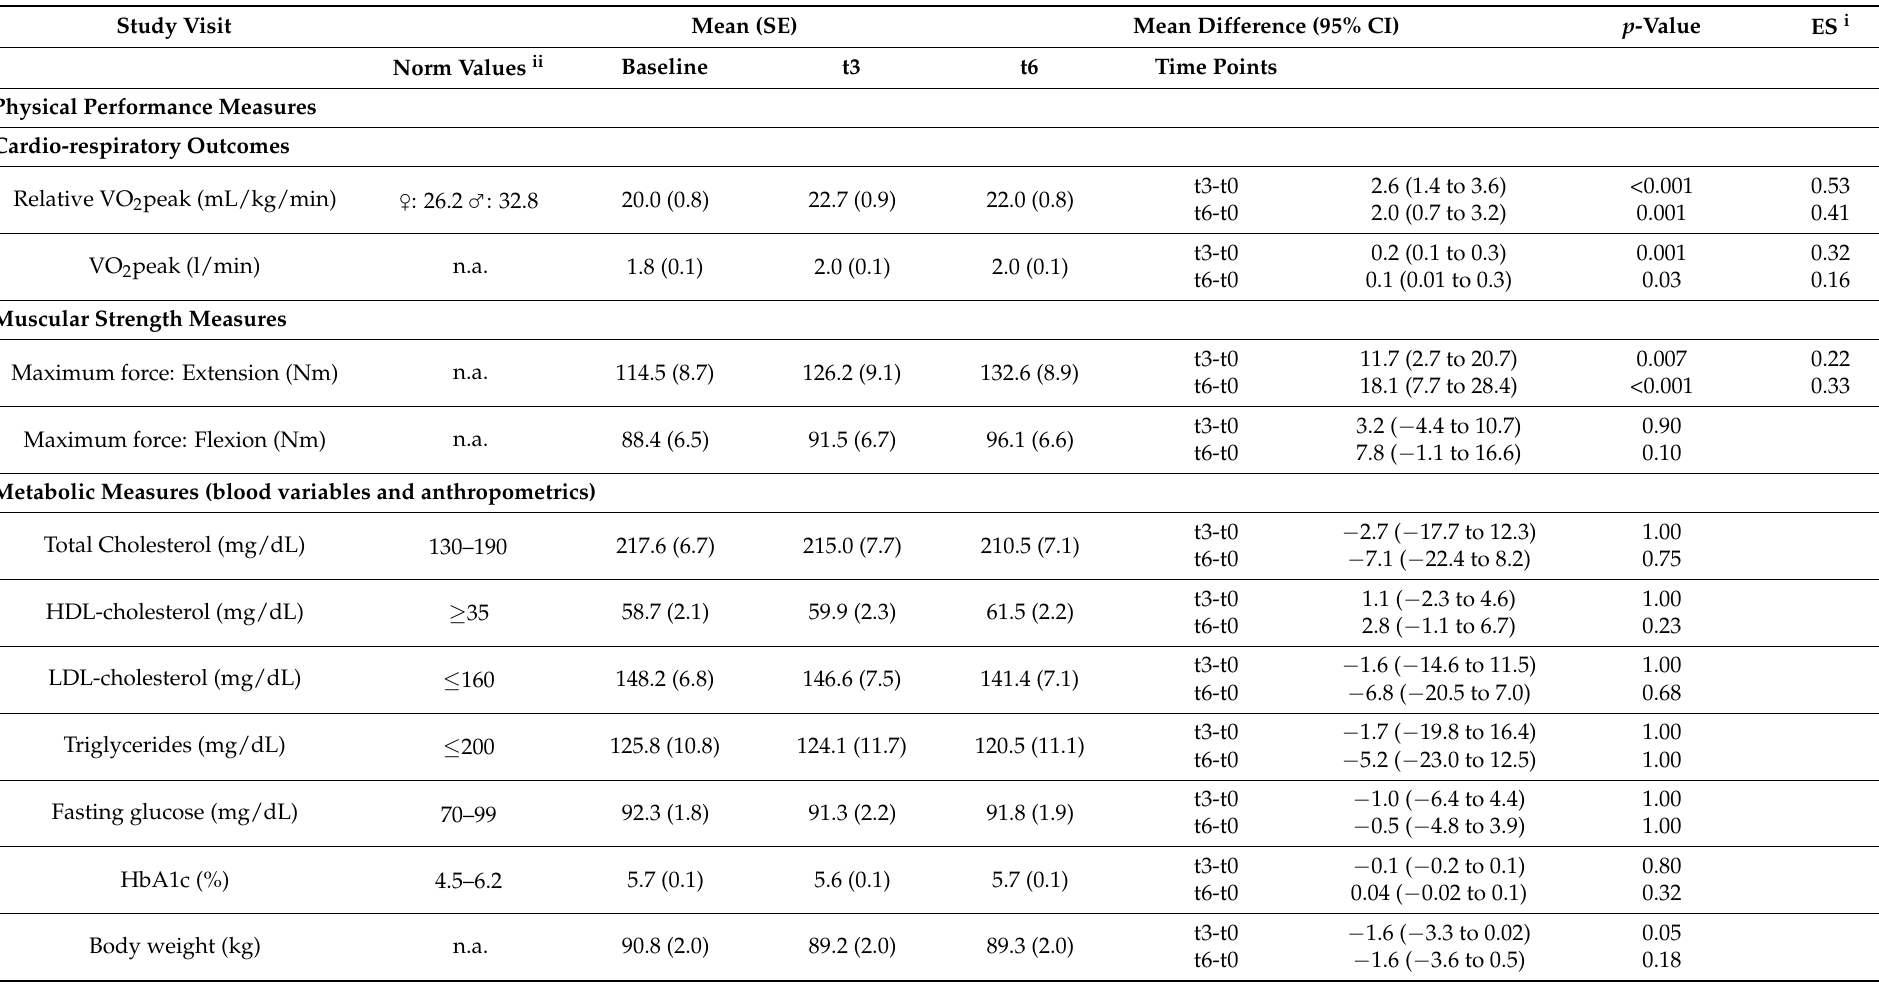
Table 4. The effectiveness of ‘MultiPill-Exercise’ intervention on physical performance measures, metabolic outcomes and health-related quality of life based on mixed model